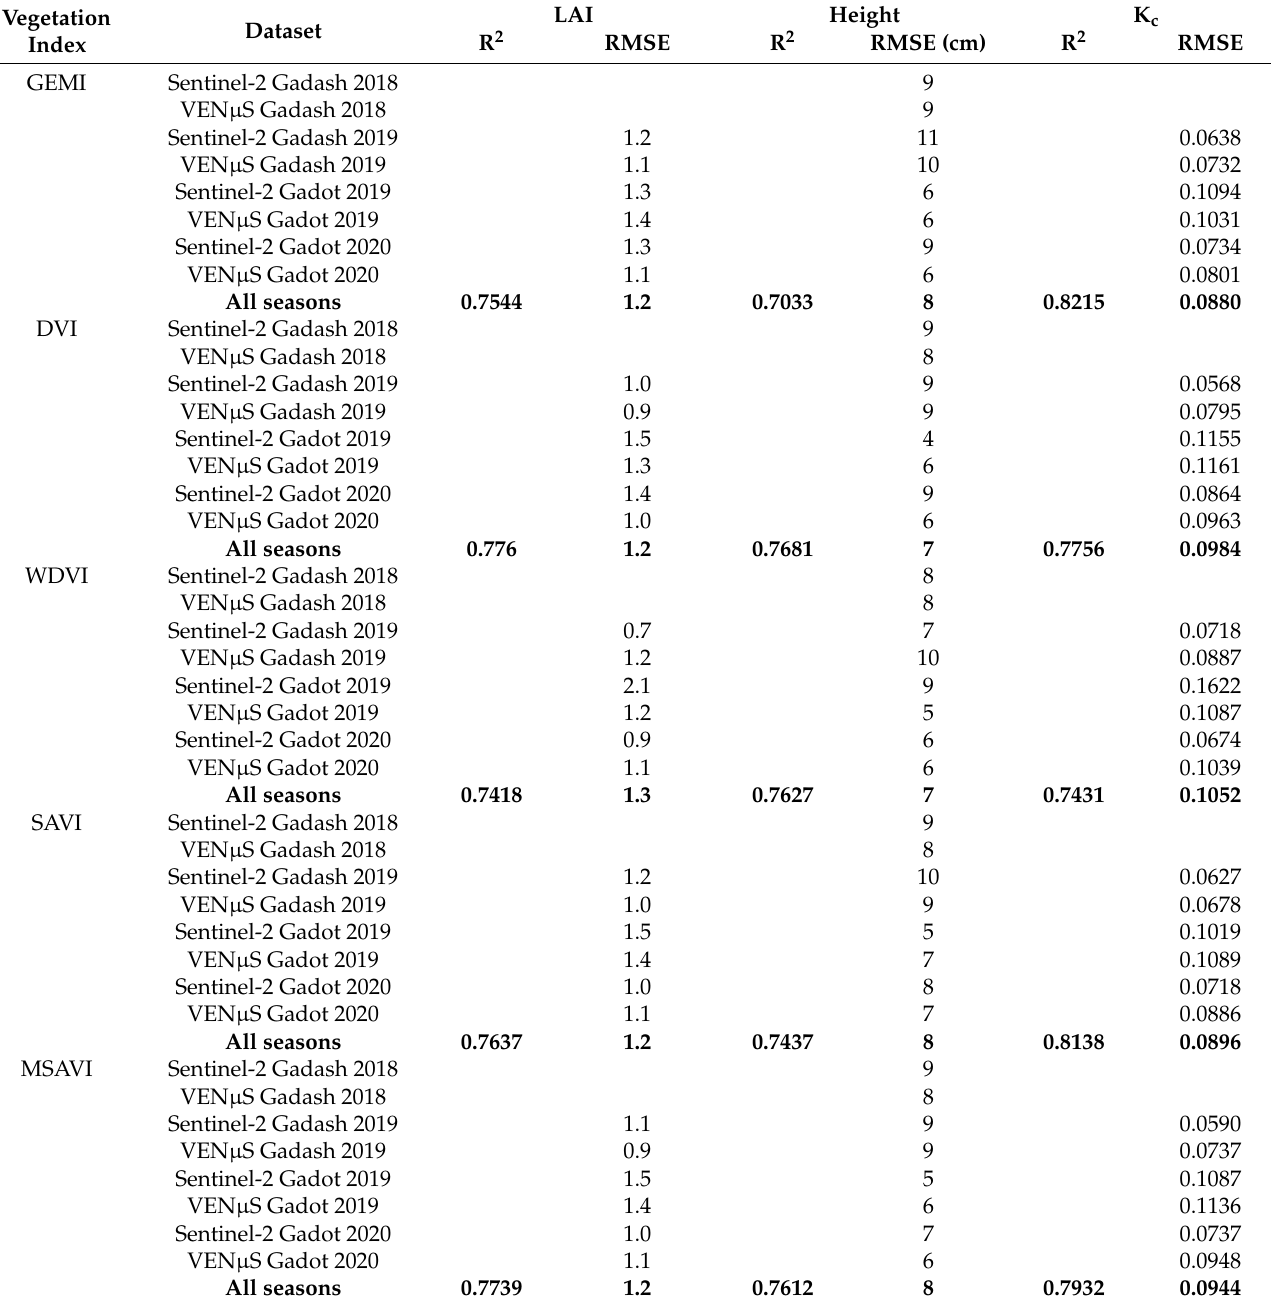
Table 6. Performance statistics of newly developed S2/V NT -based LAI, Height, K c models for the best performing VIs models. Performance statistics of additional VIs can be found in Appendix